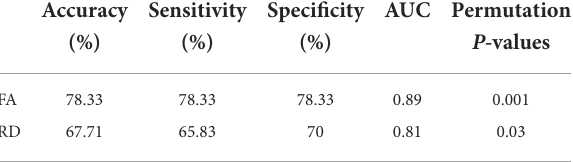
TABLE 4 MVPA classification results (10-fold